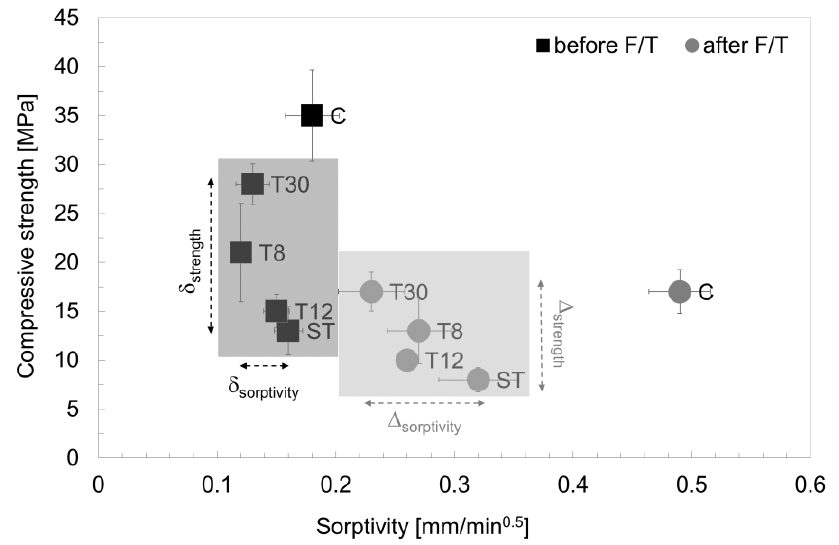
Figure 11. Sorptivity values of series C, ST, T8, T12 and T30 before and after freeze/thaw cycles compared to compressive strength values. The error bars represent the standard deviation.